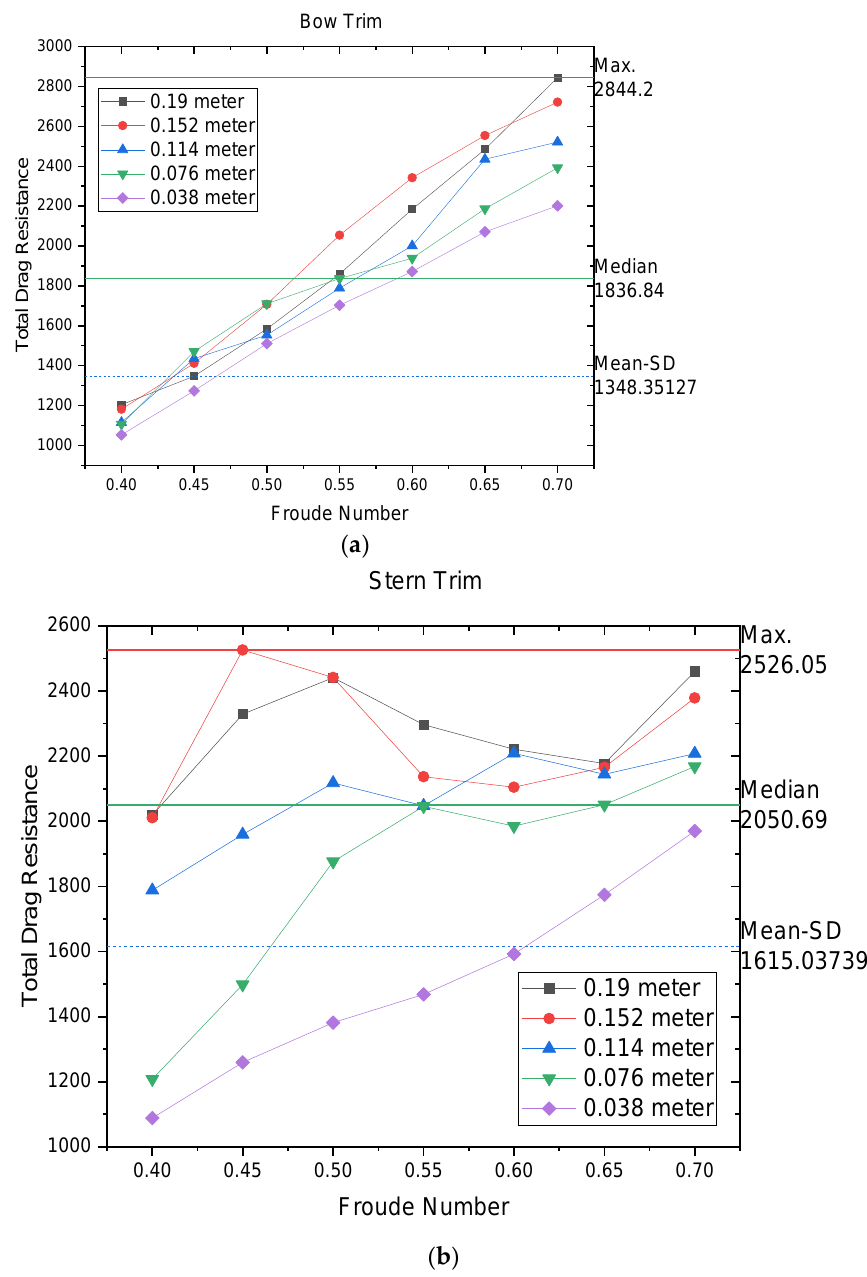
Figure 8. Total drag vs. Froude number of the trim variation on the initial design for bow trim ( a ) and stern trim ( b ).